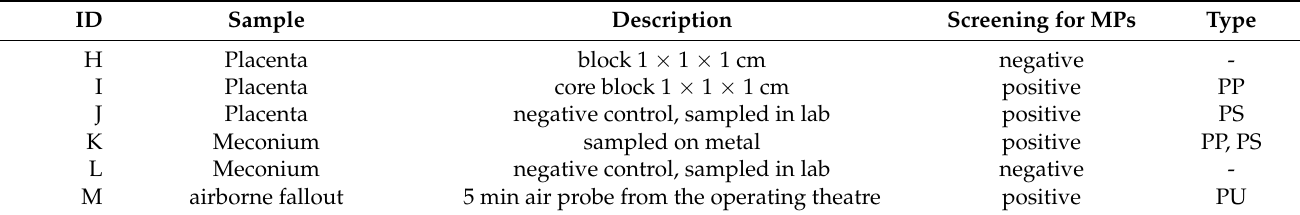
Table 2. Second phase screening for microplastic particles in human placenta, meconium and airborne fallout (0.05–0.5 mm). Negative controls include screening for MPs of the sample preparation instruments and storage containers without the actual tissues (placenta, meconium, maternal stool). PP = polypropylene, PS = polystyrene, PU =